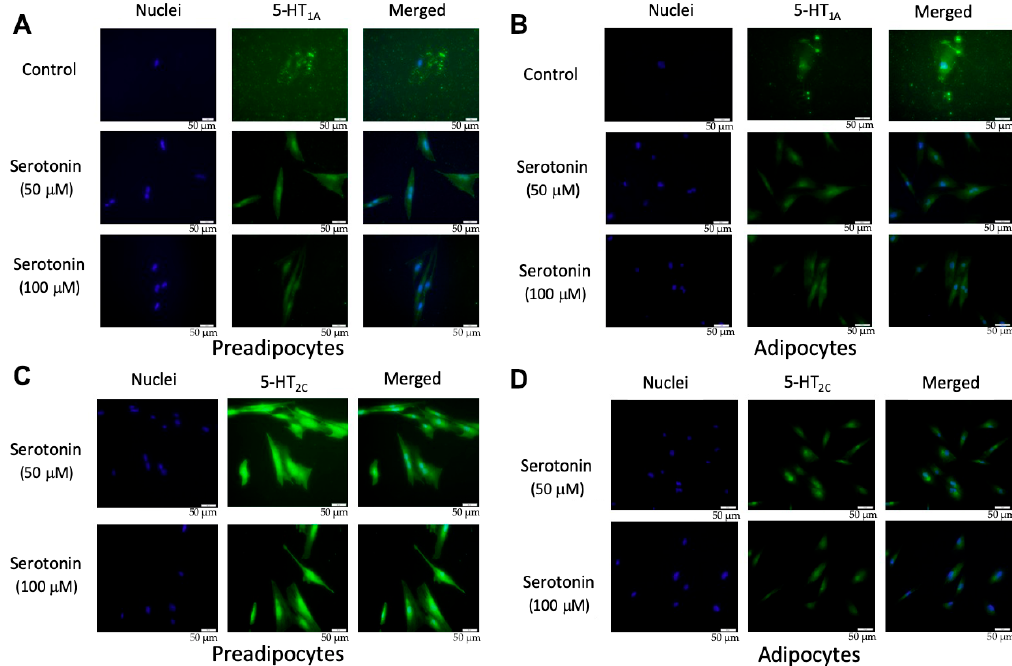
Figure 3. Expression of 5-HT 1A receptor in porcine intramuscular preadipocytes (PIP) ( A ) and in porcine mature adipocytes (pMA) of intramuscular origin ( B ); and the expression of the 5-HT 2C receptor in PIP ( C ) and in pMA ( D ). PIP cells and pMA cells were stimulated in vitro with serotonin (50 or 100 μ M), and the protein level expression of 5-HT 1A and 5-HT 2C receptors was evaluated by immunofluorescent staining. Green color indicates the signal intensity of protein expression while blue color indicates the cellular nuclei. The upper most row of the images served as a control for the 5-HT 1A receptor in unstimulated cells ( A , B ), as well as for the isotype control of 5-HT 2C receptors ( C , D ).